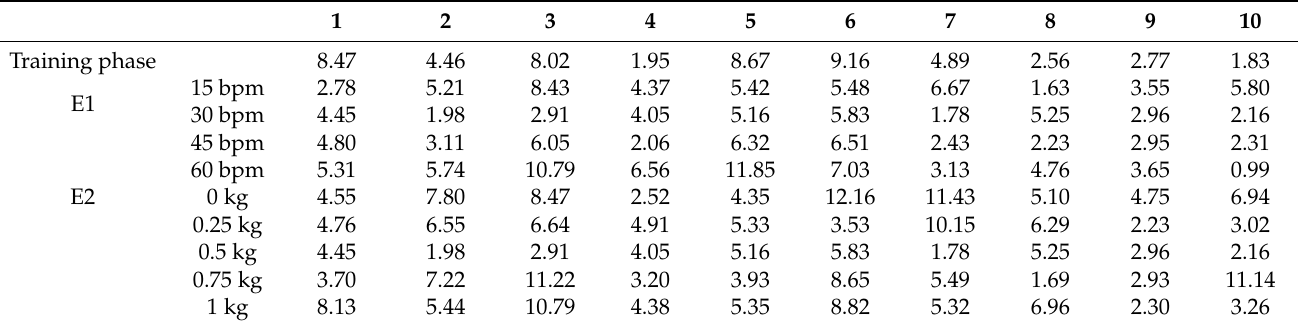
Table 3. Verification of the Training GA outputs using DTW—average deviation (in